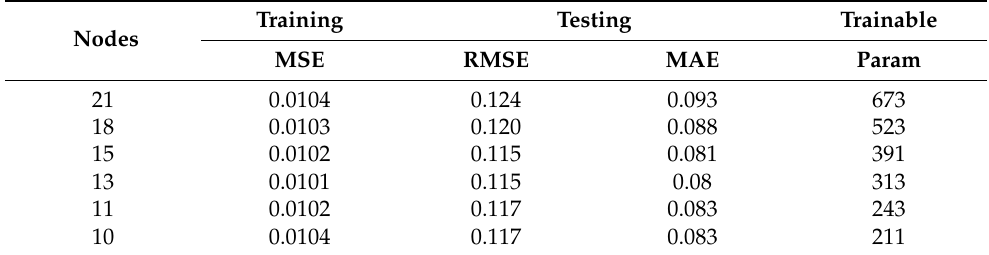
Table 4. Impact of hidden neurons on the performance of the model “RHM-1”. Training Testing Nodes